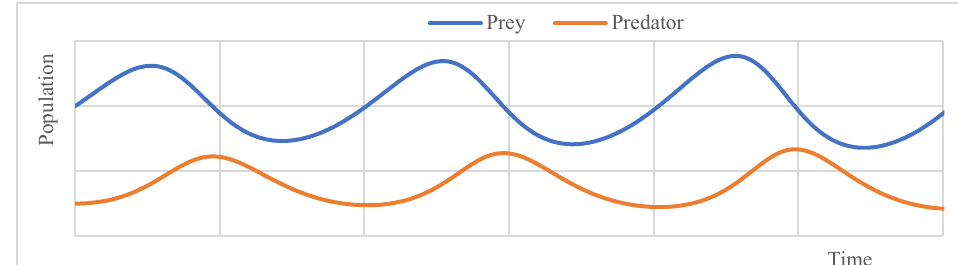
Figure 1. Example of Lotka’s model.